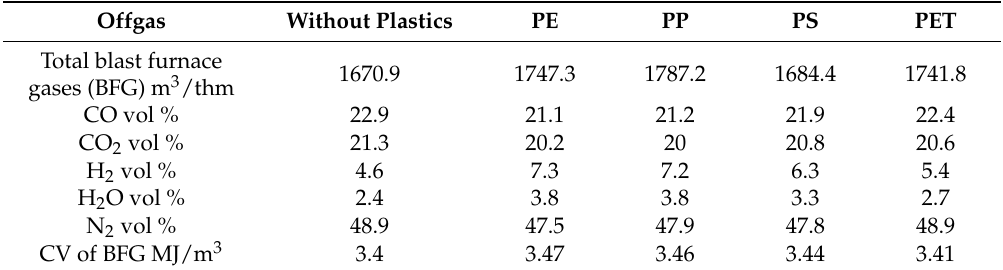
Table 4. Offgas generated from different plastic resins in blast furnace [25].